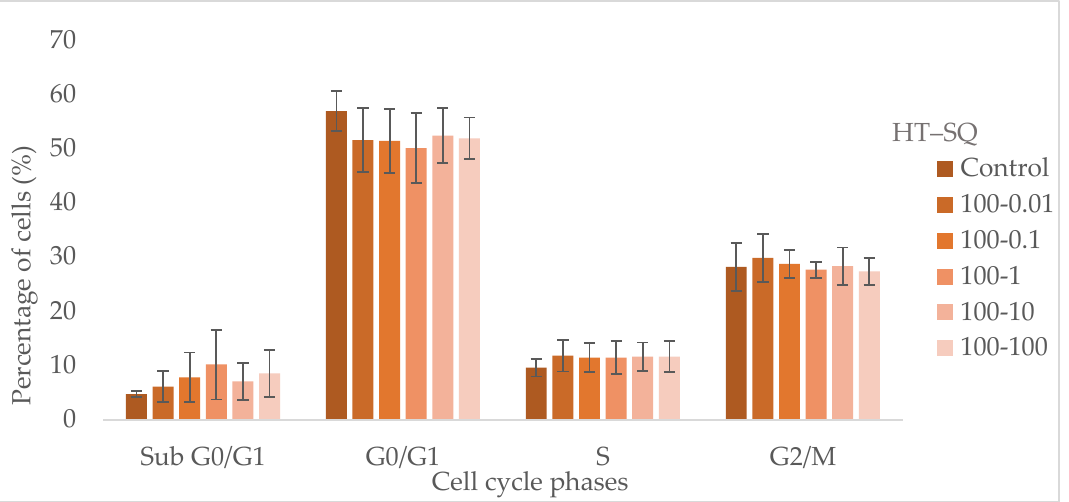
Figure 3. Distribution of cells in phases of the cell cycle for MDA-MB-231 cells after 24 h of treatment with HT at 100 μ M combined with SQ at different concentrations (from 0.01 to 100 μ M) and another 24 h of fresh medium. Data are represented as mean ± SEM of 3 independent experiments.